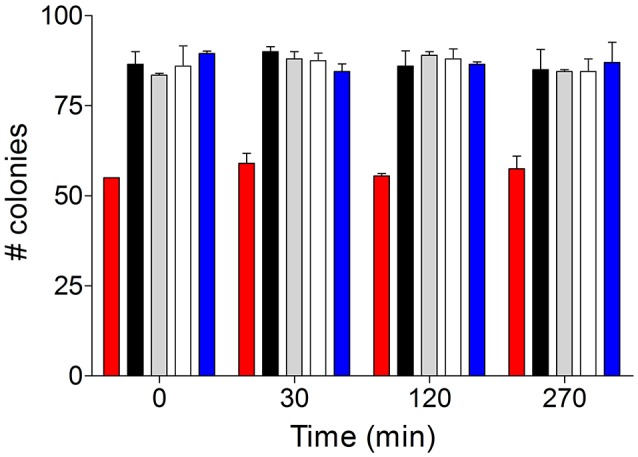
Cell viability after exposure to maltose of glucose-pregrown cultures of S. eubayanus CBS 12357T (), S. cerevisiae IMZ616 (), IMX1253 (SeMALT1) (), IMX1254 (SeMALT2) () and IMX1255 (SeMALT3) (). Cells from glucose-grown batch cultures were resuspended in SM. Prior addition of 20 g L−1 of maltose, the initial viability was measured by sorting 96 cells per strain on SMUG plates. The SMUG cultures were sampled after 30, 120 and 270 min. The viability data are represented as averages ± mean deviations of three independent experiments for each strain.